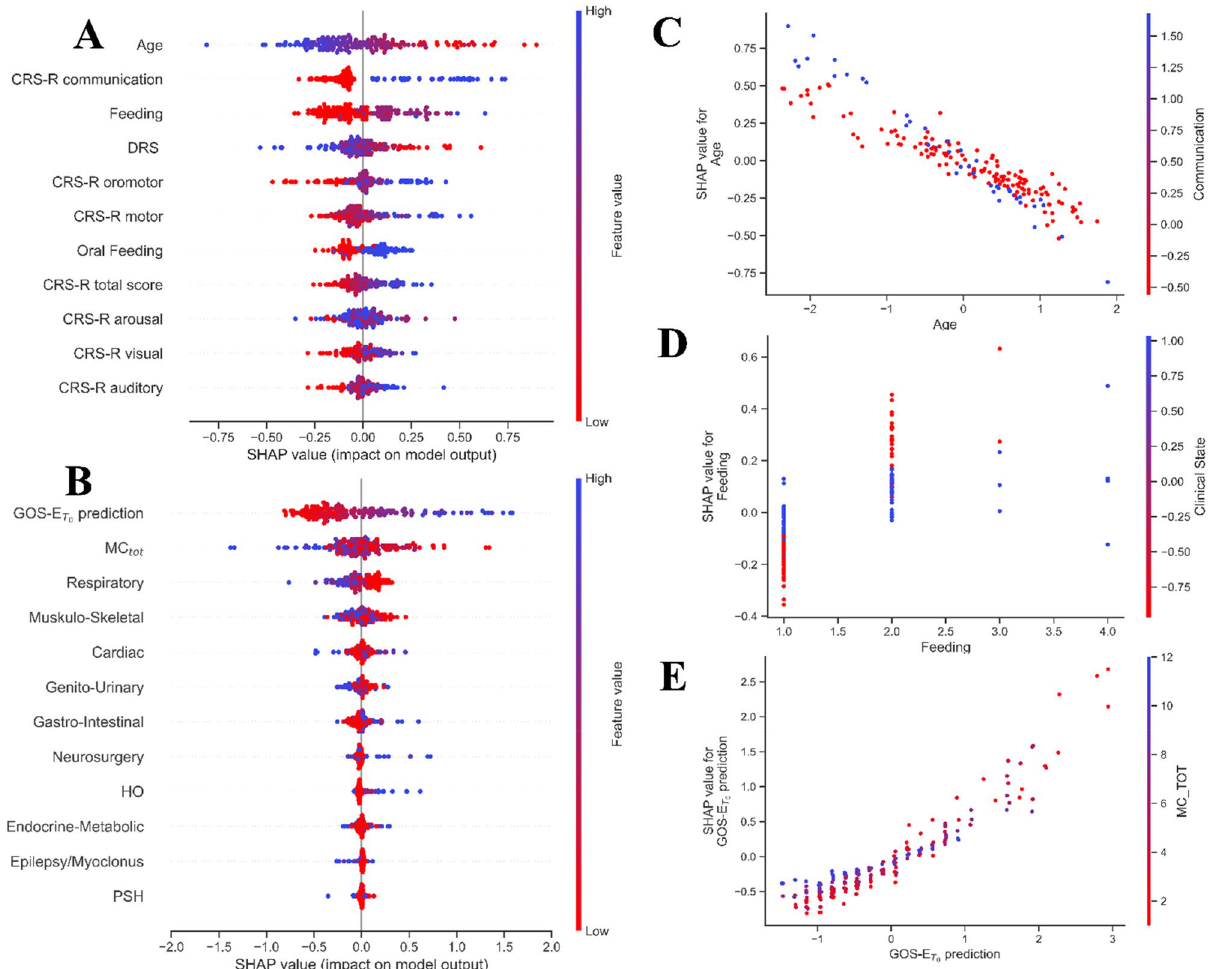
Figure 3. SHAP values were computed for both the admission KNN ( A ) and the 3-months KNN–KNN ( B ) and they are reported on the x-axis, after ordering features by the mean of the absolute SHAP value. Most relevant marginal interactions are represented for both the admission model ( C , D ) and the 3-months model ( E